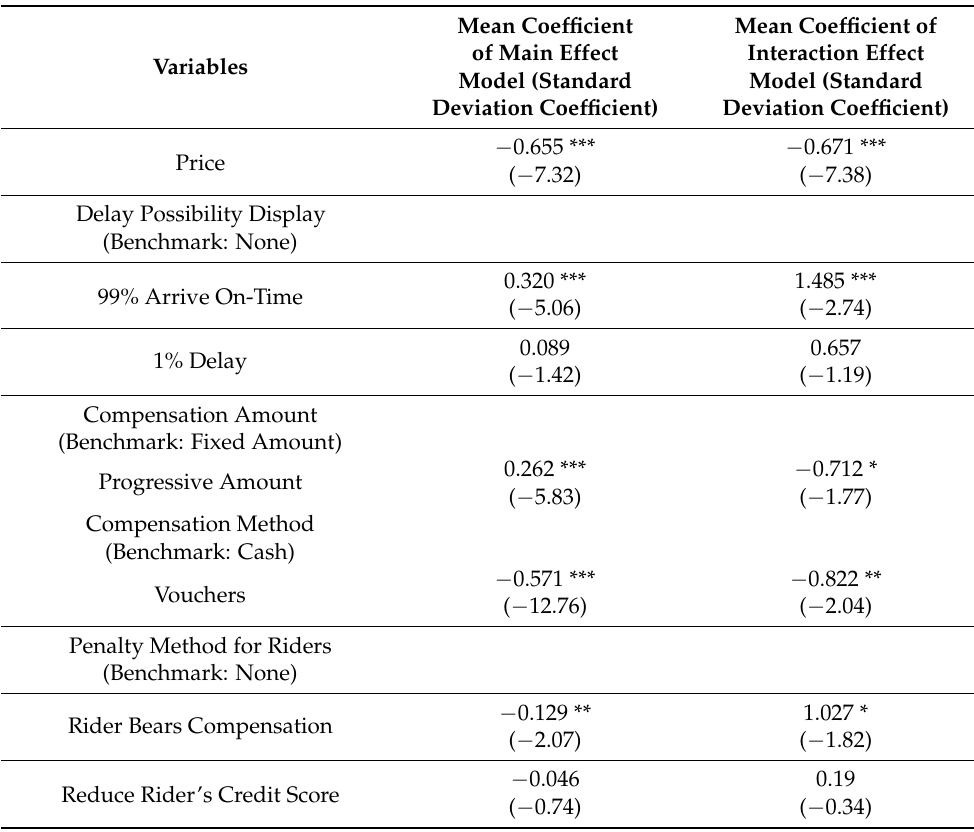
Table 4. Results of the Multinomial Logit MNL